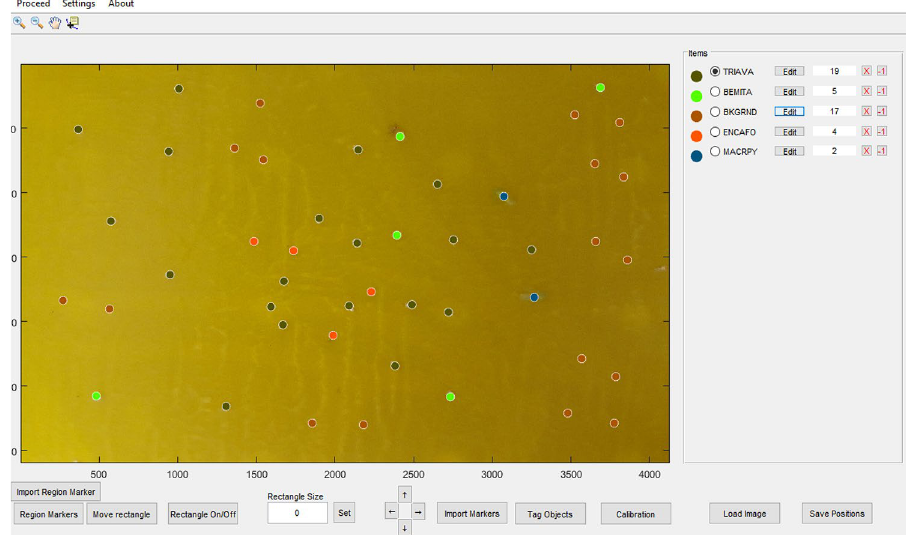
Figure 5. Manual labelling of the YST by the “ImgObjectLocator” software. With this tool, individuals can be marked and located in a YST. Manual labelling then provides automatic segmentation of the original image to sub-images of species, which finally gives the training data.